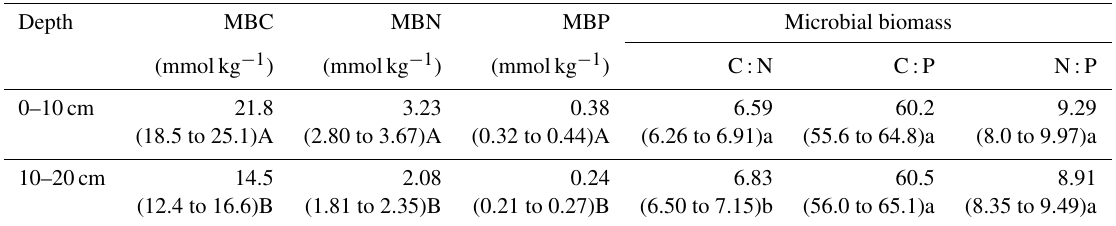
Table 2. The microbial biomass C, N, and P concentrations and microbial C:N:P stoichiometric ratios across the Inner Mongolian grassland at different soil